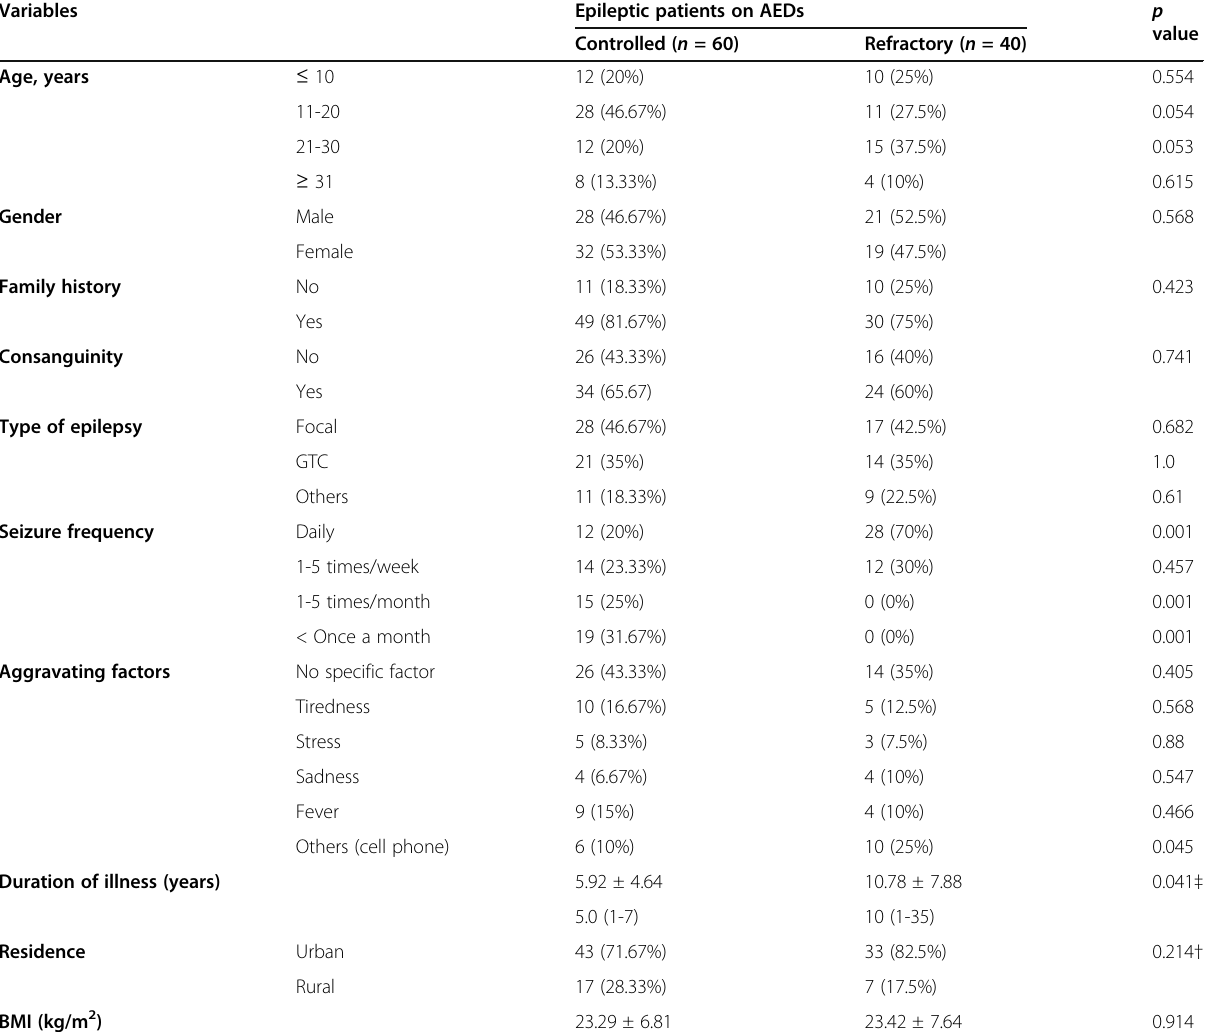
Table 2 Demographic and clinical data of epileptic patients Variables